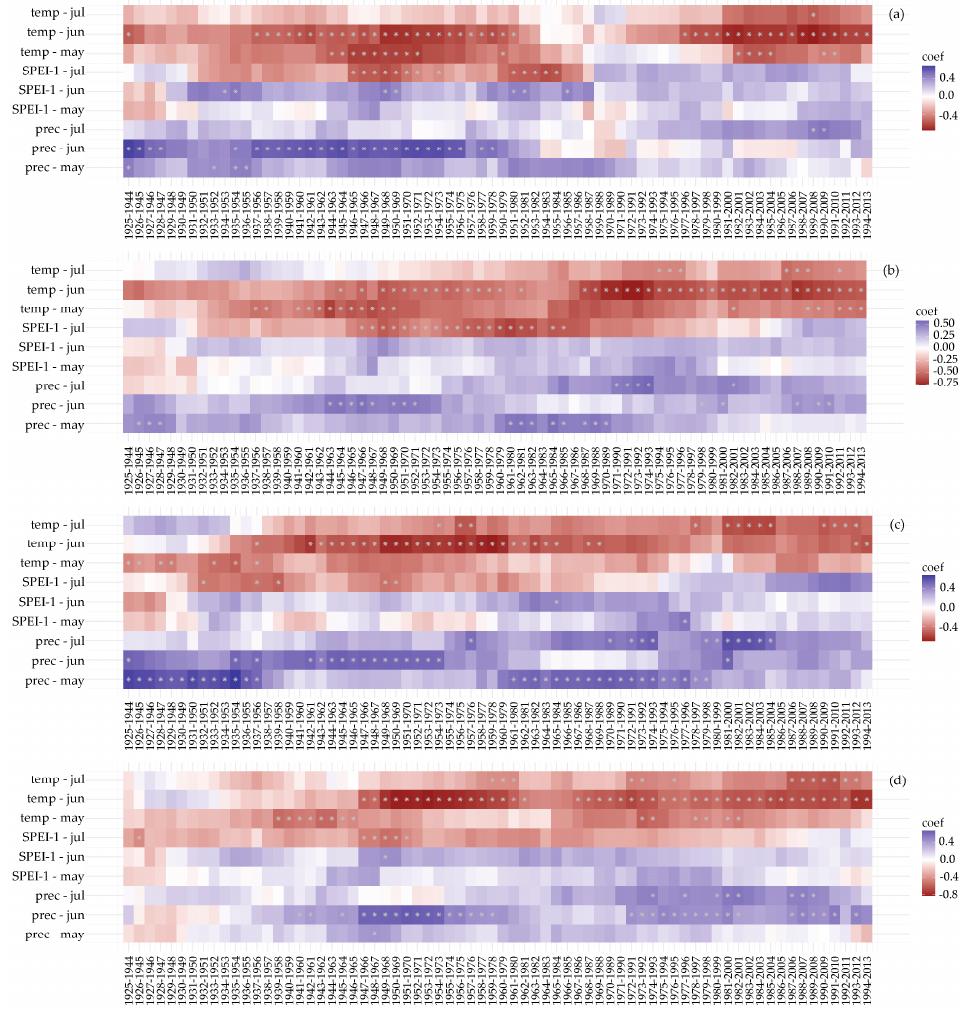
Figure 3. Moving correlation function relating ARI chronologies of P. asperata ( a ), P. tabuliformis ( b ), L. gmelinii ( c ) and Q. mongolica ( d ) to air temperature, precipitation and SPEI-1 of May, June and July of the current year. The moving correlation is carried out in windows of 20 years, offset by 1 year. The stars in the plot indicate windows with significant correlations for the given variable.